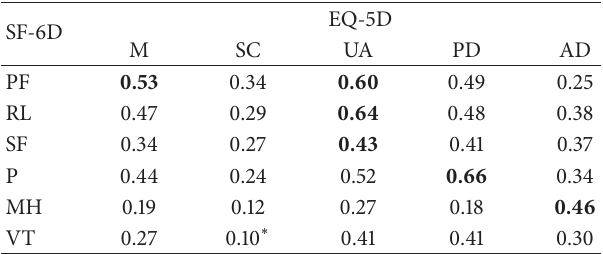
Table 1: Correlations between dimension scores in the SF-6D and EQ-5D.